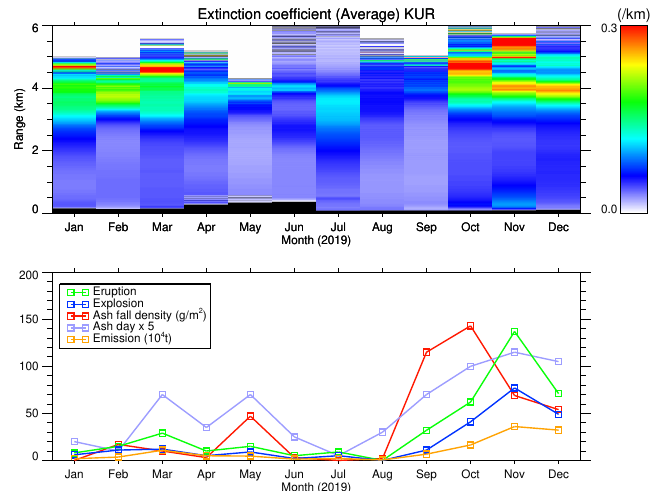
Figure 7. Time-range plot of aerosol extinction coefficients ( top , determined by the KUR lidar, 532 nm) and eruptive activity at Sakurajima in 2019 ( bottom , see Figure 3 for details). The number of ash fall days is rescaled by a factor of 5.